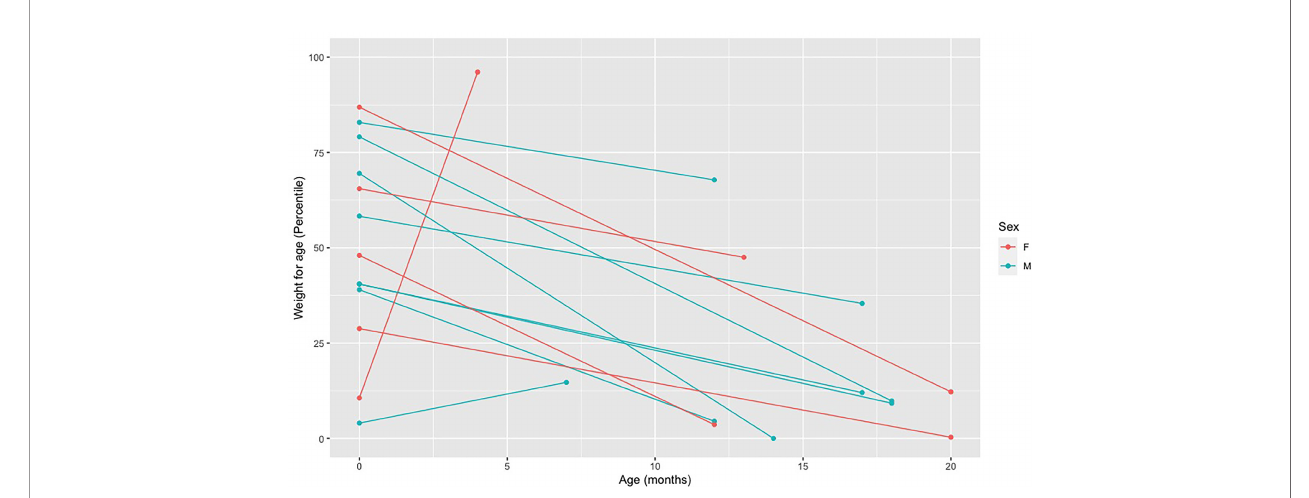
FIGURE 4 | Decreased in weight percentile from birth to diagnosis in affected individuals. Each point represents a weight measure in percentile taken at a different age. The fi rst dot (far left) represents the weight at birth and the second dot represents the weight at the age of diagnosis. The two dots of each individual are connected by a